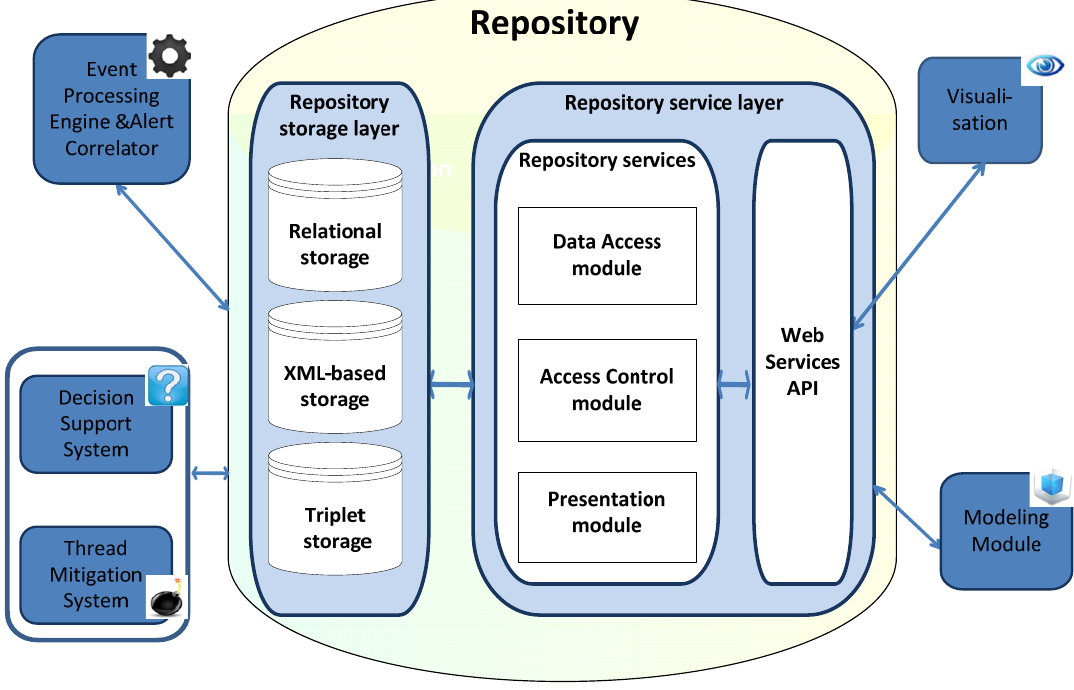
Figure 7. Repository